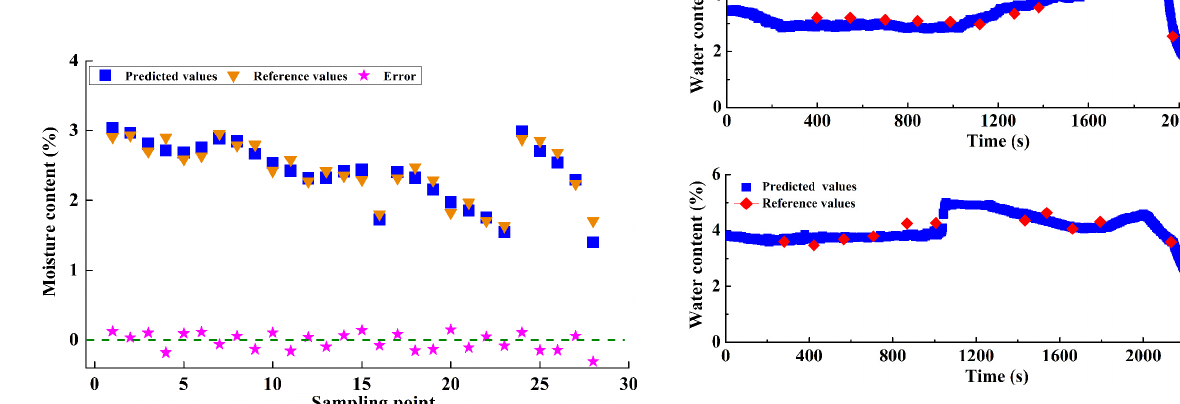
Fig. 6. The validation for the models of moisture content.